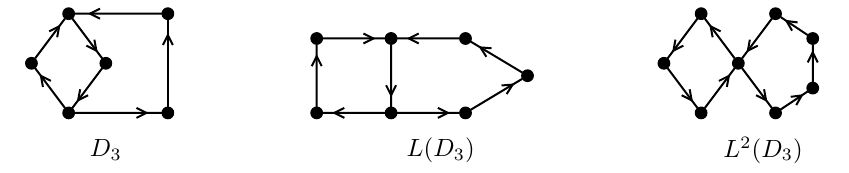
Figure 13: Another example of line iterates of a digraph with a pair of joined cycles.